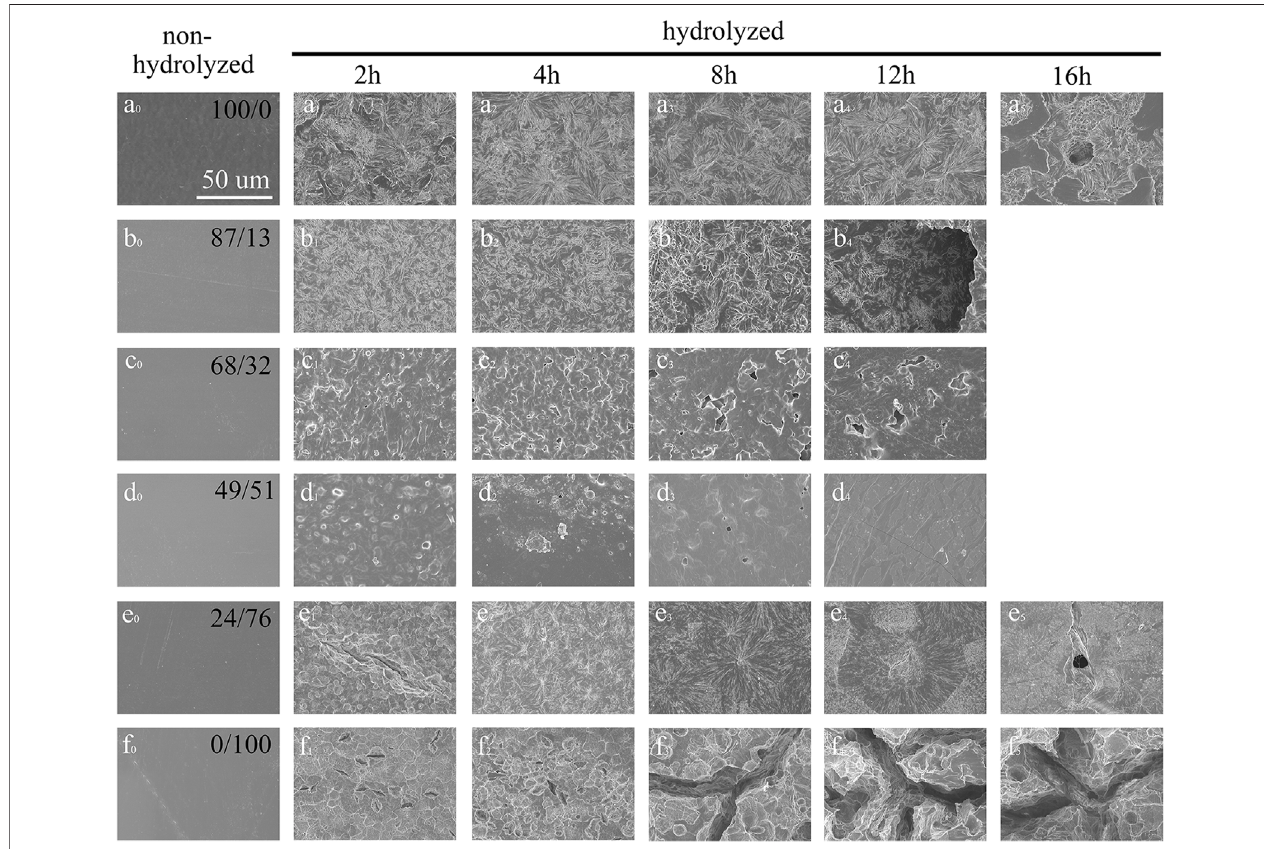
FIGURE 6 | SEM images of the polyester fi lms after enzymatic hydrolysis with cutinase. (A – F) : PHS, P(HS- co -13ES), P(HS- co -32ES), P(HS- co -51ES), P(HS- co - 76ES), and PES.